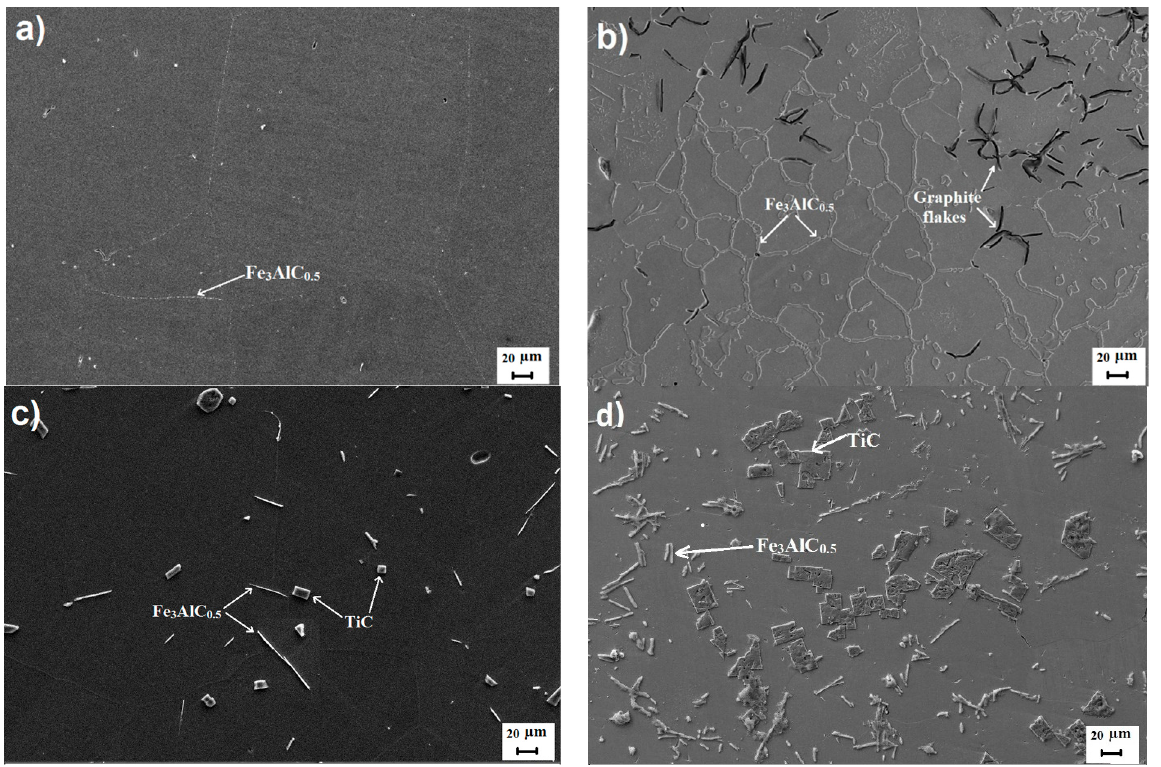
Figure 1. SEM images of FeAl-based alloys ( a ) C01T0 with fine Fe 3 AlC 0.5 , ( b ) C1T0 with graphite and coarse Fe 3 AlC 0.5 , ( c ) C01T1 with Fe 3 AlC 0.5 and TiC and ( d ) C1T5 with Fe 3 AlC 0.5 and TiC.